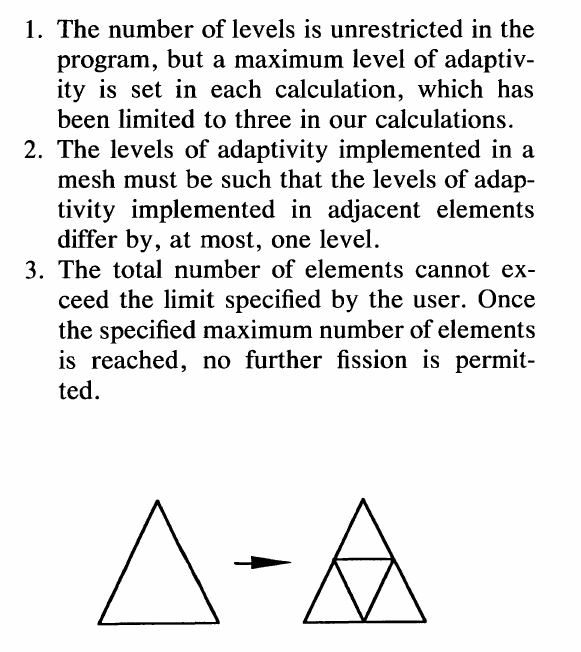
FIGURE 2 Fissioning of a triangular element.